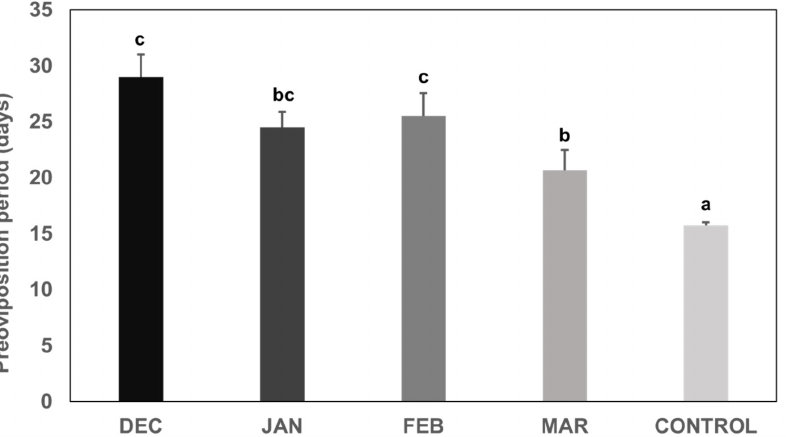
Figure 3. Preoviposition period (mean ± S.E., n = 60) of Halyomorpha halys females that overwin- tered in natural outdoor conditions until December 2020, January, February and March 2021 and were then transferred to 26 °C. A laboratory colony maintained at 26 °C was used as control. Different letters above bars indicate statistically significant differences ( p < 0.001).